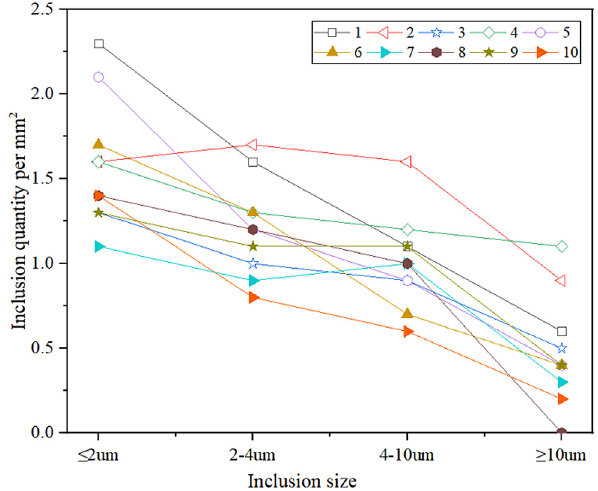
Figure 4: The size distribution of